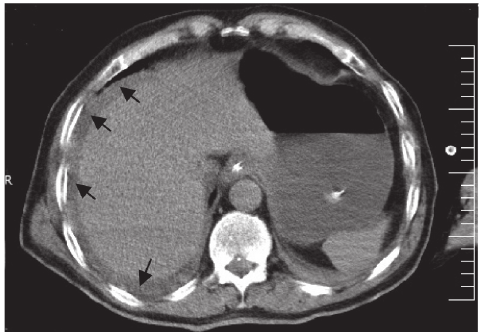
Figure 1: Male patient’s chest CT.